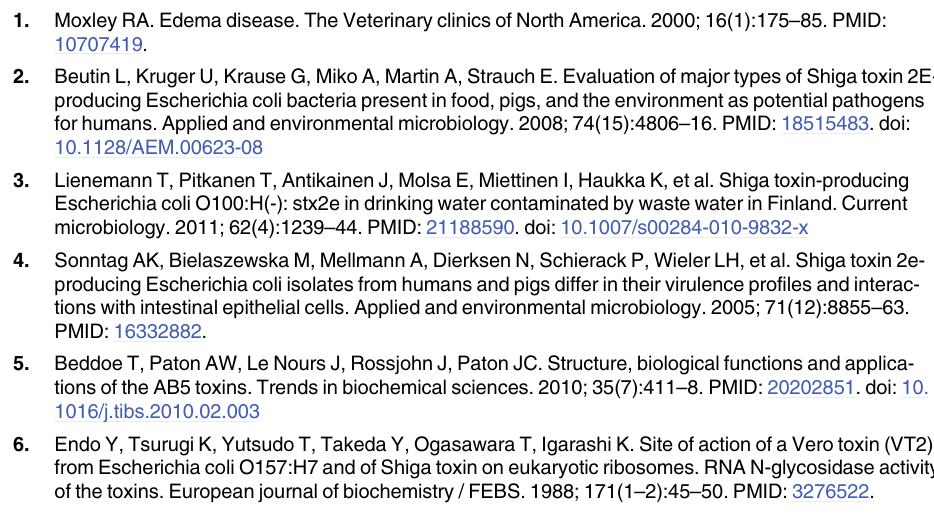
S1 Fig. Single-antibody sandwich ELISAs for B-subunit subtype specificity. mAbs Stx2e-1 and Stx2e-2 were used in single-antibody sandwich ELISAs (same antibody for capture and detection) to detect Stx2 subtypes in cell-free media. Media was used at a 10-fold dilution in PBS. Detection antibodies were biotinylated and used at 0.5 ug/mL. Log scale is used due to variation in the amount of each Stx2 subtype present in the media. S1 File. Raw data for quantitative experiments (ELISAs, cell viability assays) is provided here. S1 Table. mAb combinations for Stx2 subtype-specific ELISAs. mAb combinations used to distinguish Stx2a, Stx2c, and Stx2d were analyzed for their ability to detect the seven Stx2 sub- types. Cell-free media (at a 10-fold dilution in PBS) from the seven Stx2 subtypes was